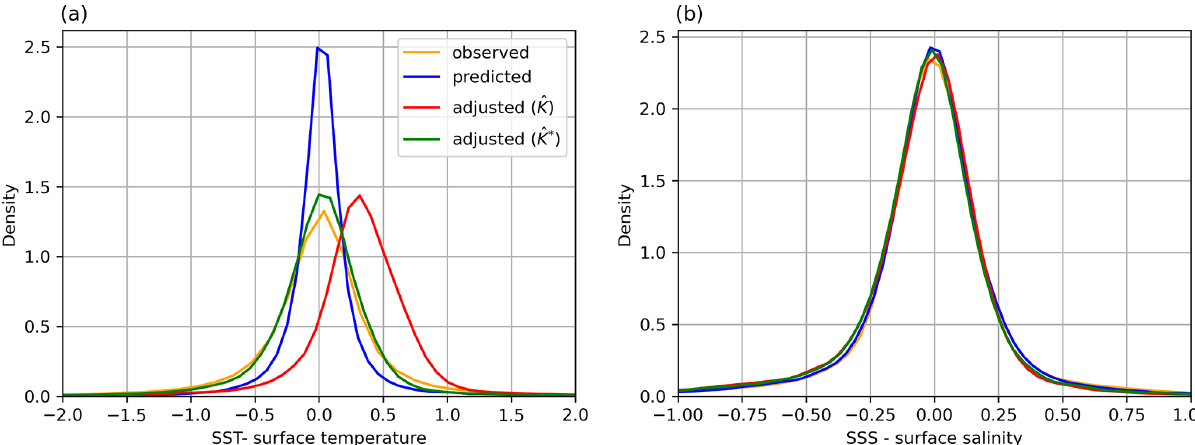
Figure 5. Density distribution of the difference between the in situ surface temperature and salinity and the remote sensing SST and SSS. The predicted profiles (blue) correspond to the profiles produced by the NN alone. The adjusted distribution with ˆ K is in red (also red in Fig. 4d). The adjusted distribution with ˆ K ∗ is in green and corresponds to the OSnet product (i.e., NN + adjustment), also shown in green in Fig. 4d. Table 2. Metrics of accuracy for predictions of Armor3D, Glorys12, a neural network (NN, i.e., OSnet without MLD adjustment) and OSnet compared to the in situ CORA profiles. The σ 0 inversions larger than 0 . 01kgm − 3 are counted. The Armor3D and Glorys12 statistics are computed on the subsampled products at the locations of the profiles of CORA. CORA Armor3D Glorys12 NN OSnet: NN +